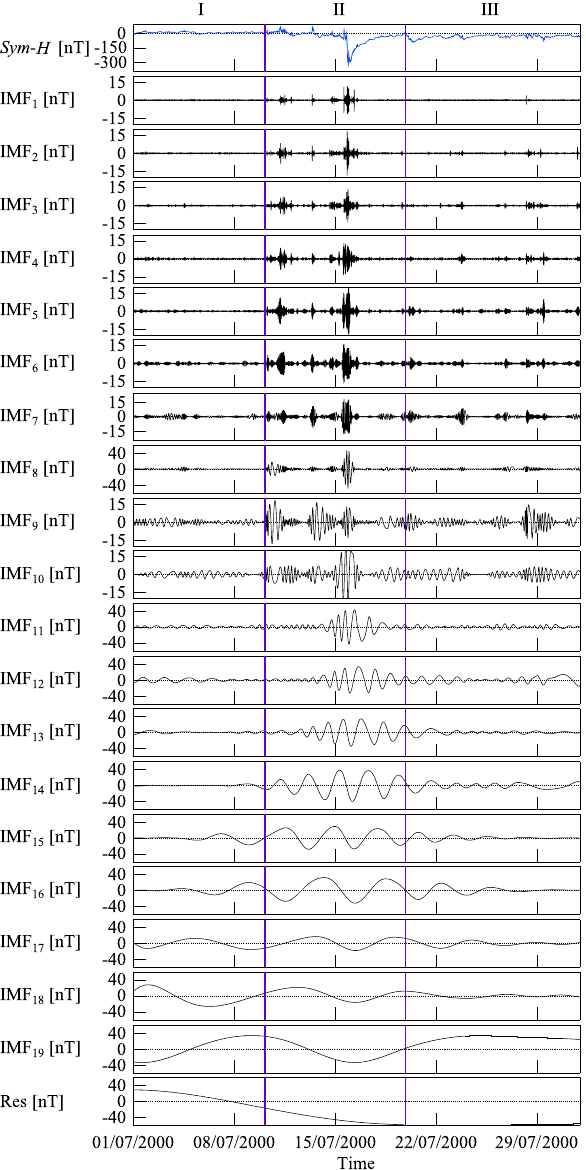
Fig. 2. From top to bottom: Sym-H time series for the time period B , from 1 July 2000 to 31 July 2000; 19 IMFs and residue resulting from EMD. Vertical lines denote the separation into three subin- tervals (I, II, III). The characteristic scale increases with the mode number k